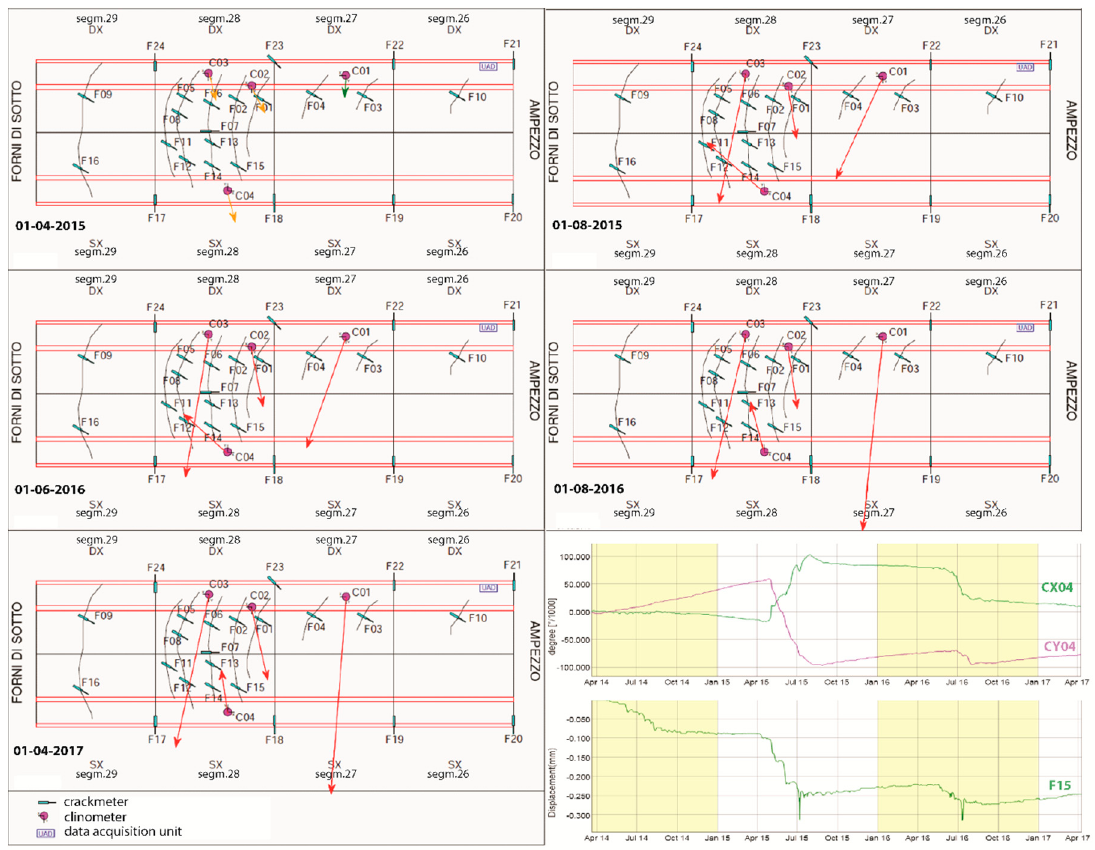
Figure 13. Vector representation of the rotation of the clinometers in the tunnel; bottom left: the rotation recorded by clinometer C04 associated with the displacements recorded by crackmeter F15.